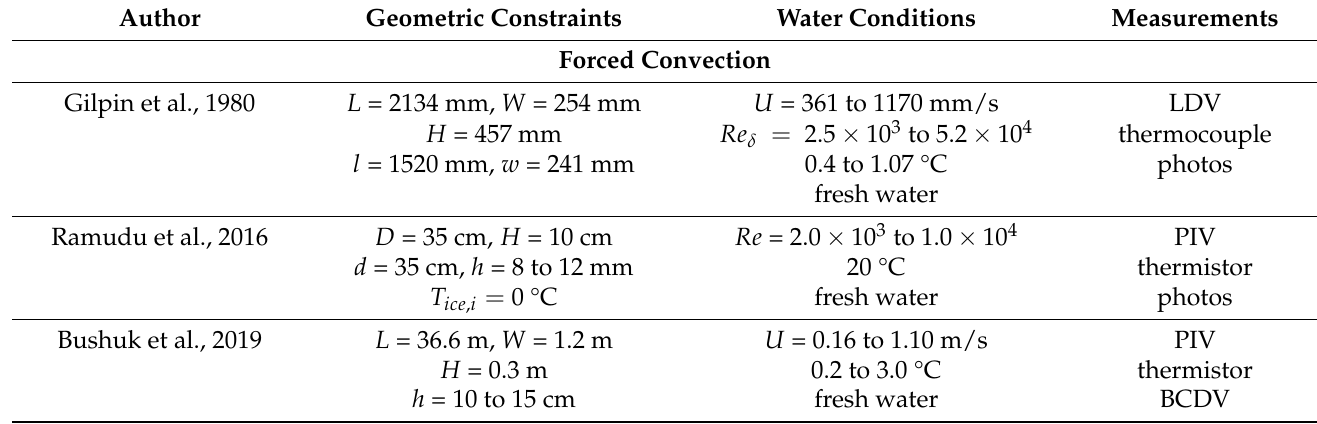
Table A2. Experiments focused on flow patterns and melting above horizontal ice in forced convection.